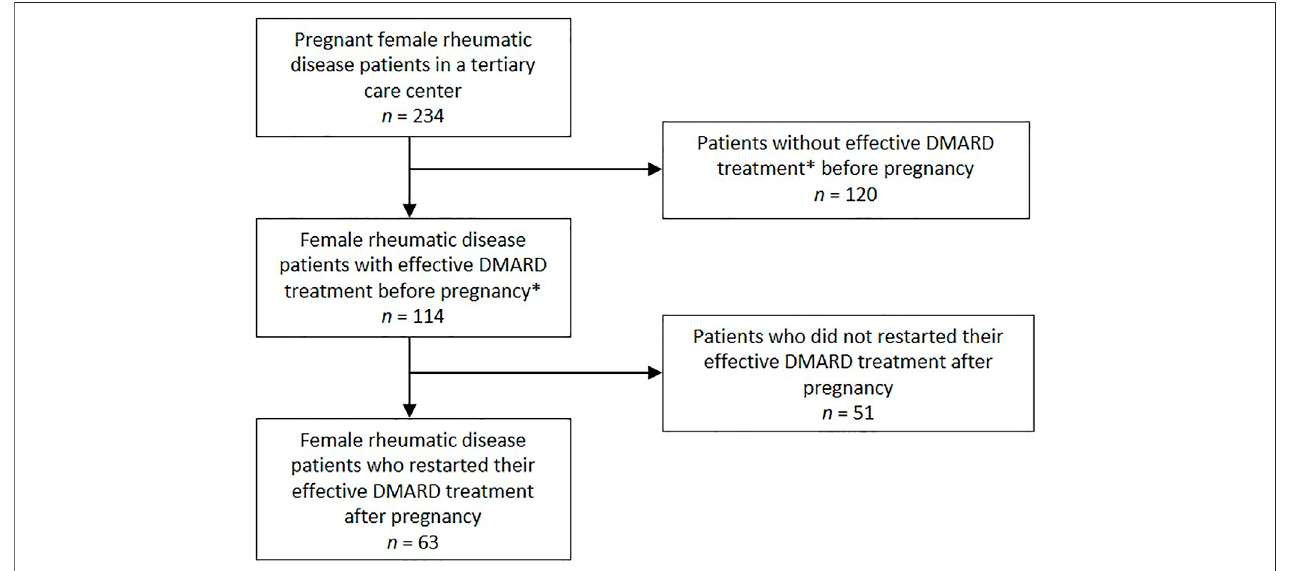
FIGURE 1 | Flowchart of pregnant patient selection from the PreCARA cohort. * Effective treatment was de fi ned as continuous treatment for at least 1 year.